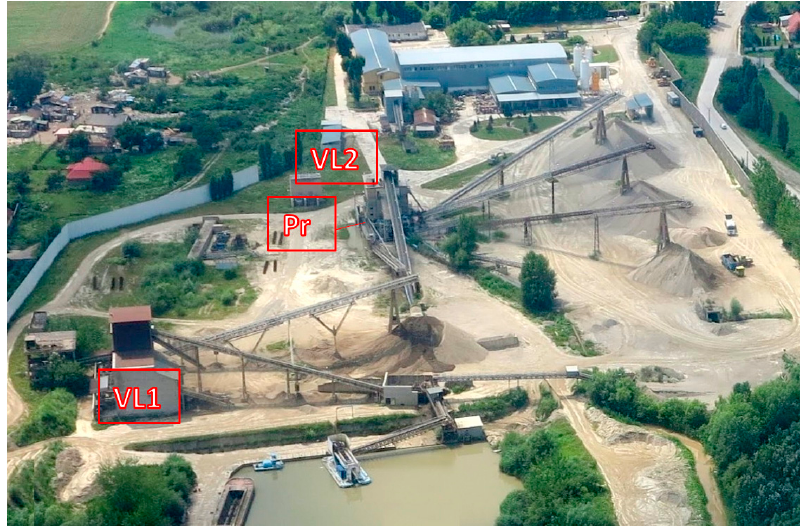
Figure 1. Sandy gravel production plant.